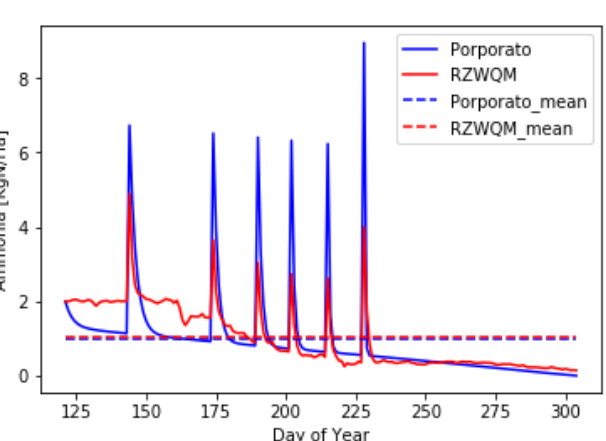
Figure 9. Plot of ammonia concentration by two models for each day of year of the growing season.